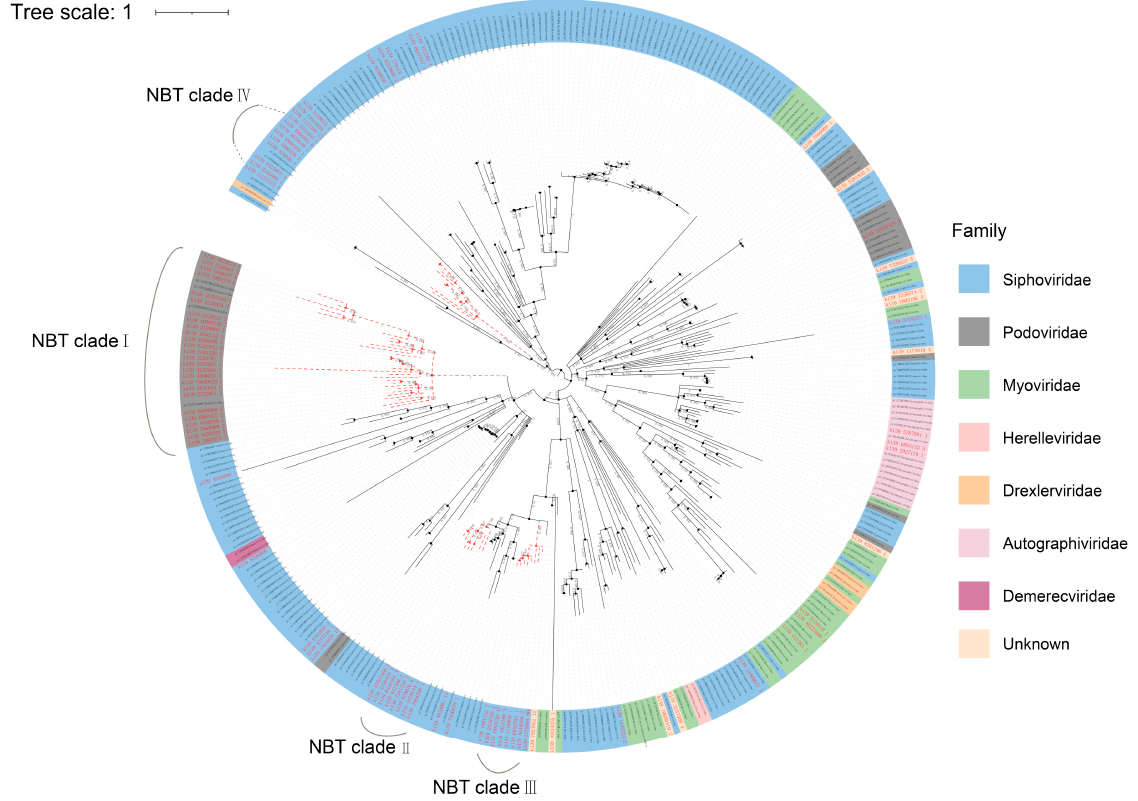
Figure 5. Phylogenetic analysis of Caudovirales based on TerL using the maximum likelihood algorithm. A FastTree approximate maximum-likelihood phylogenetic tree was built using TerL. Reference viral sequences from NCBI are colored in black. Scale bar, one amino acid substitution per site.